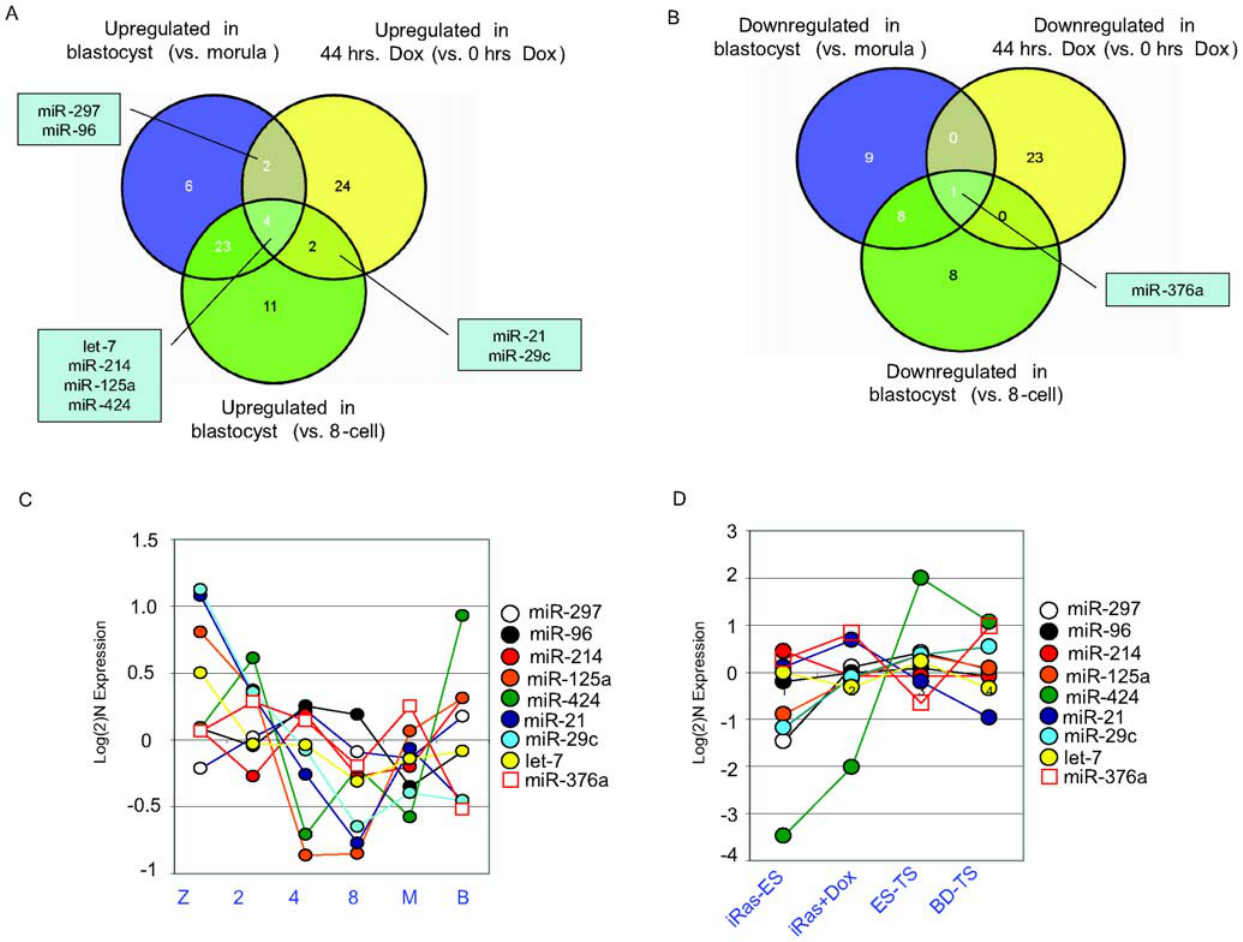
Figure 5. Candidate miRNAs involved in trophectoderm specification and maintenance of pluripotency. a) Venn diagram showing miRNAs that are differentially expressed during trophectoderm specification both in vitro and in vivo . b) Venn diagram showing candidate pluripotency-specific miRNAs that are expressed highly both in undifferentiated ESCs and in blastocysts. c) Expression of the nine candidate miRNAs established in Fig. 5a–b) during embryonic development. The average expression across all let-7 family members is depicted as a single circle. d) Expression of the nine candidate miRNAs established in Fig. 5a–b) in iRas-ESCs, iRas + Dox_48 hrs, ES-TS (signal averaged for Clone 38 and Clone 41), and BD-TS cells. The average expression across all let-7 family members is depicted as a single circle.